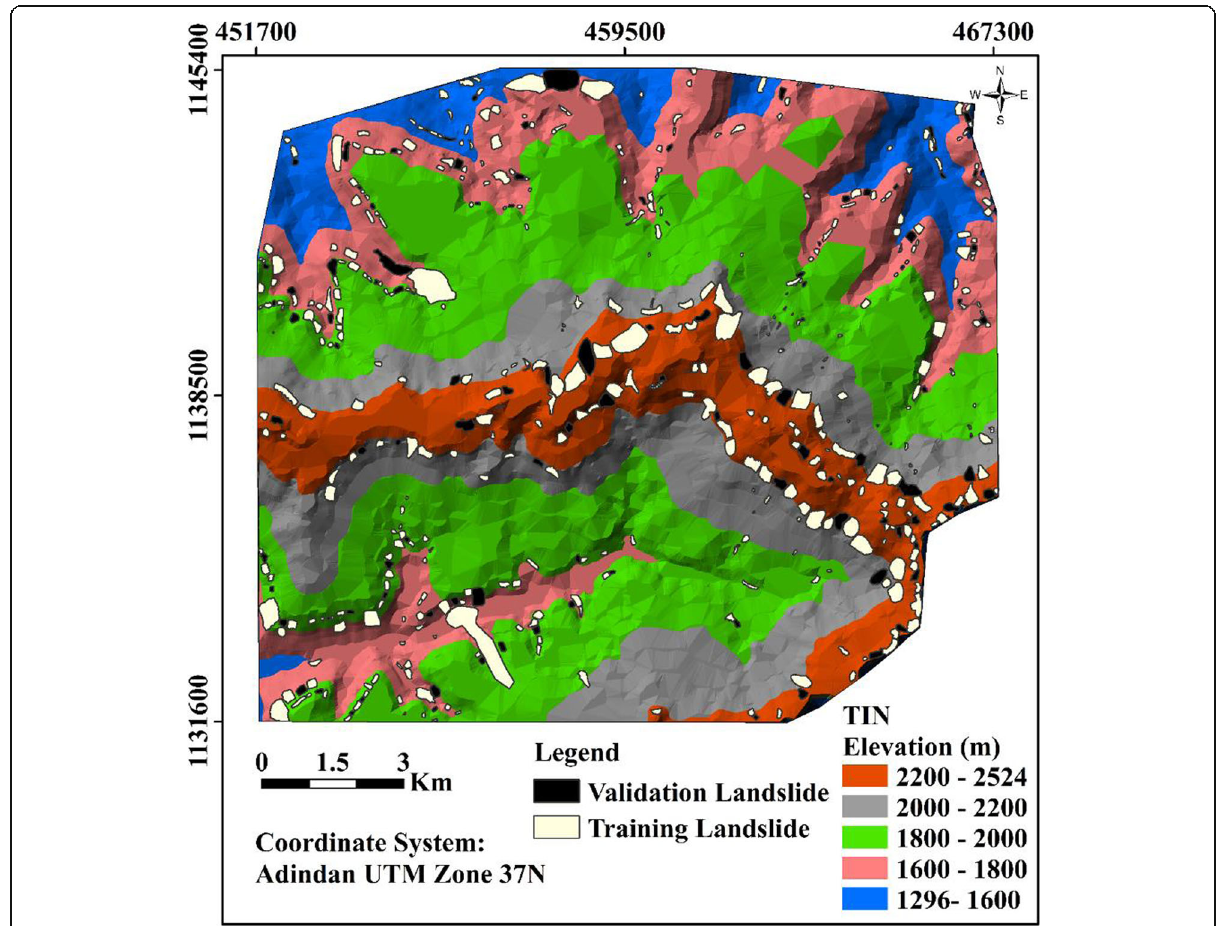
Fig. 3 Landslide inventory map of the study